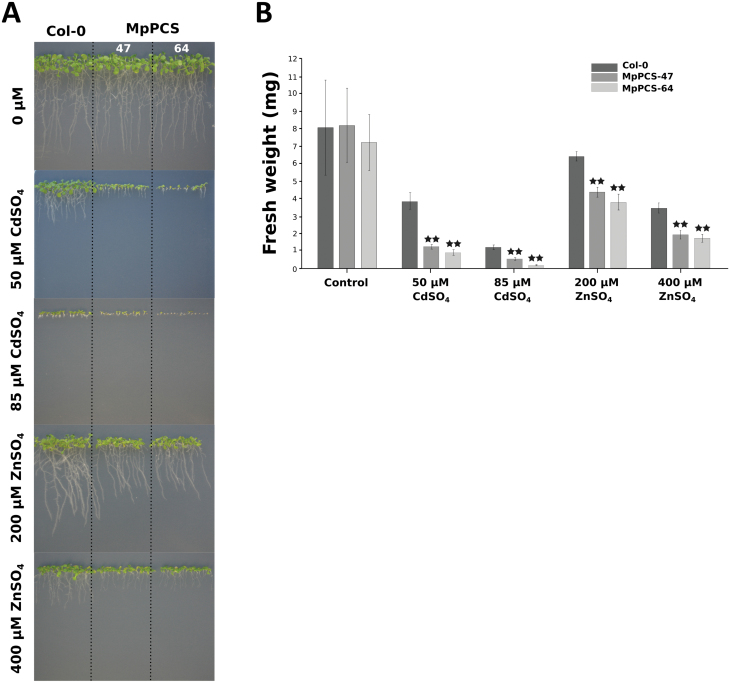
Phenotypic variations upon CdSO4 or ZnSO4 treatment of Arabidopsis transgenic plants overexpressing MpPCS from M. polymorpha. (A) Phenotypes of 10-day-old MpPCS transgenic and wild-type Col-0 plants under non-treated (top) and treated conditions with different concentrations of CdSO4 (50 µM and 85 µM; middle) or ZnSO4 (200 µM and 400 µM; bottom). Dashed lines indicate the separation of different genotypes. (B) Fresh weight of the corresponding plants shown in (A); bars represent the SD of three biological replicates, and two stars indicate statistically very significant differences compared with Col-0. At least 60 plants were used for each analysis.